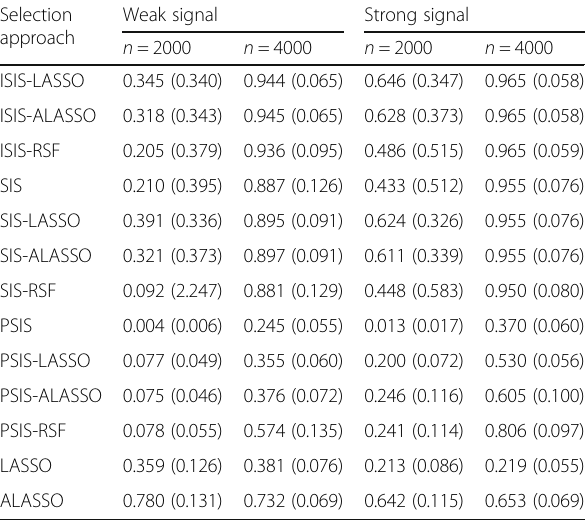
Table 5 Mean (SD) of C H for the testing sets over 300 simulations Selection approach